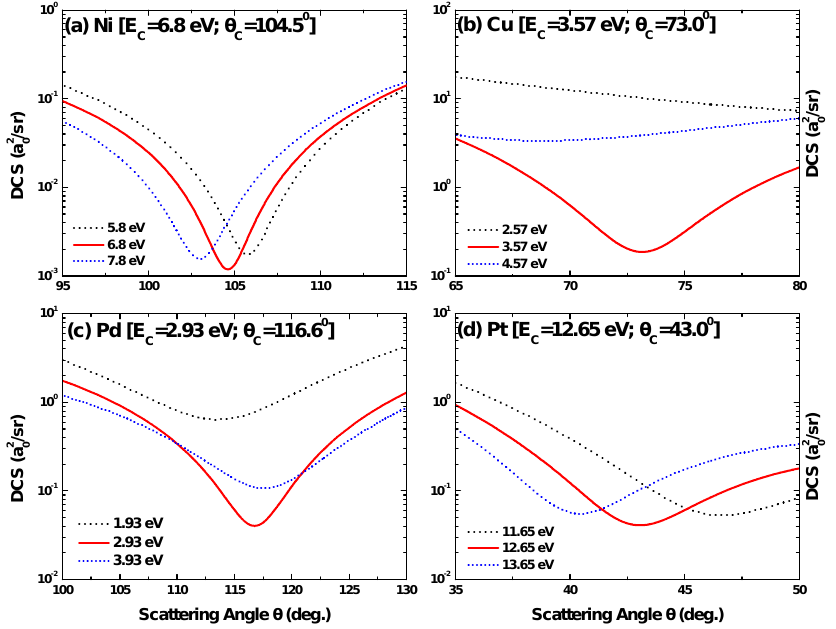
Figure 18. Angular dependence of the DCS for three incident energies in the vicinity of the critical minima: ( a ) ( E c = 6.8; θ c = 104.5 ◦ ) for Ni, ( b ) ( E c = 3.57; θ c = 73.0 ◦ ) for Cu, ( c ) ( E c = 2.93; θ c = 116.6 ◦ ) for Pd, and ( d ) ( E c = 12.65; θ c = 43.0 ◦ ) for Pt.